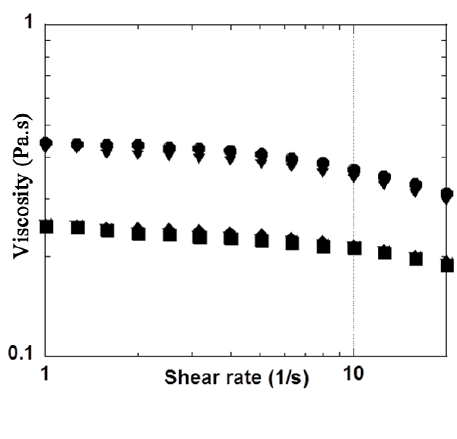
Figure 2. Measurement of the steady state viscosity  as a function of the shear rate of four solutions of hyaluronic acid (HA):  HA/PBS;  HA/mannitol/PBS;  HA/mannitol + xanthine;  HA/mannitol + xanthine + xanthine